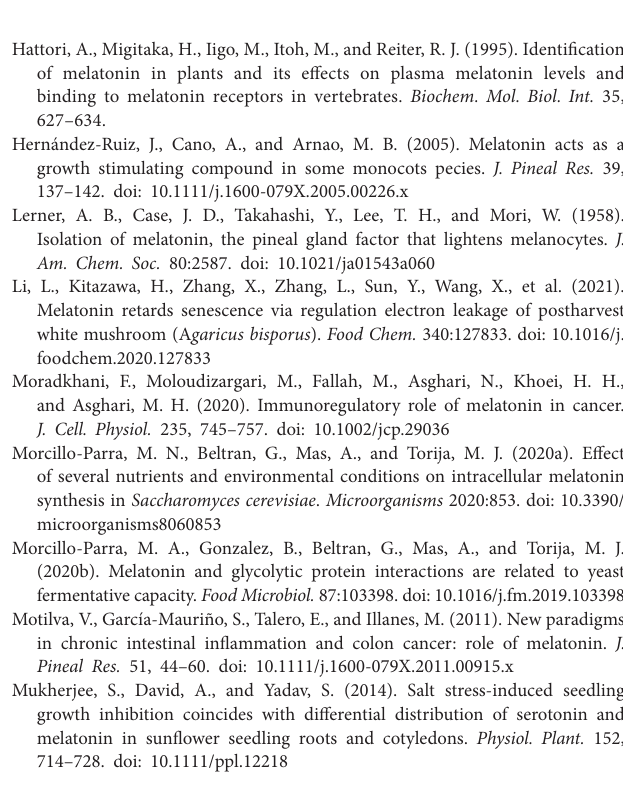
Supplementary Figure S1 | Effect of different concentration melatonin on the mycelial growth of T. guangdongense . Supplementary Table S1 | Information of genes related to melatonin